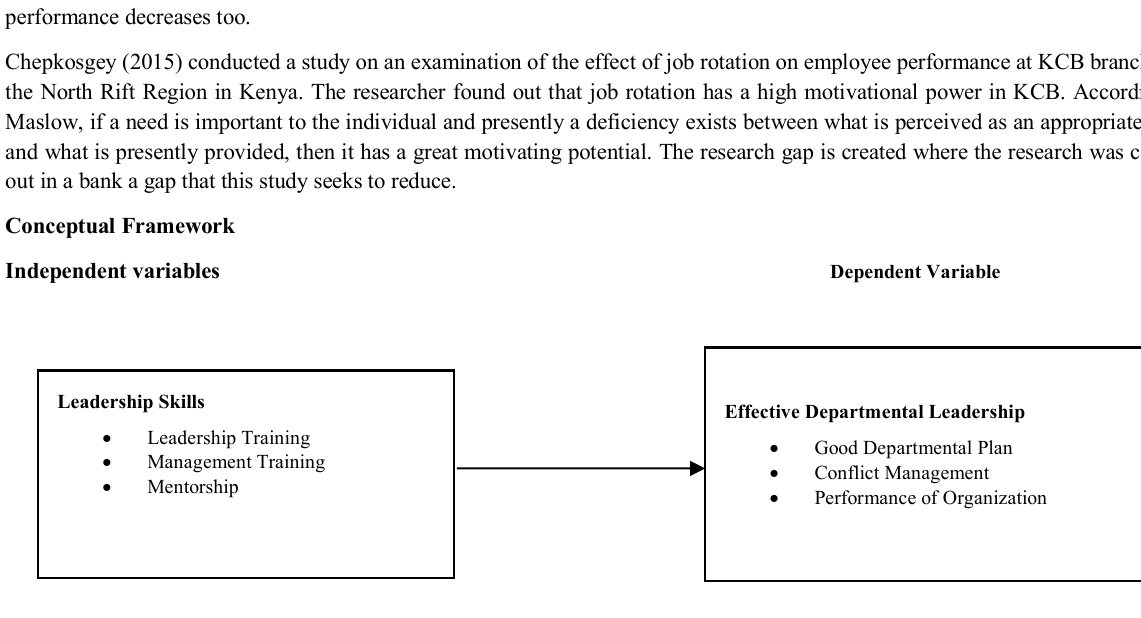
Figure 1: Influence of Leadership Skills on Effectiveness of Departmental